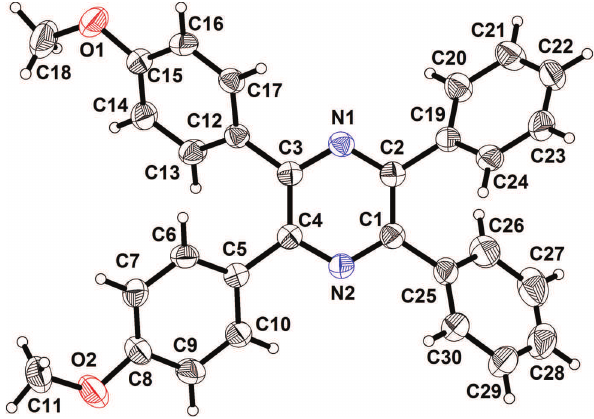
Table 1: Data collection and handling.